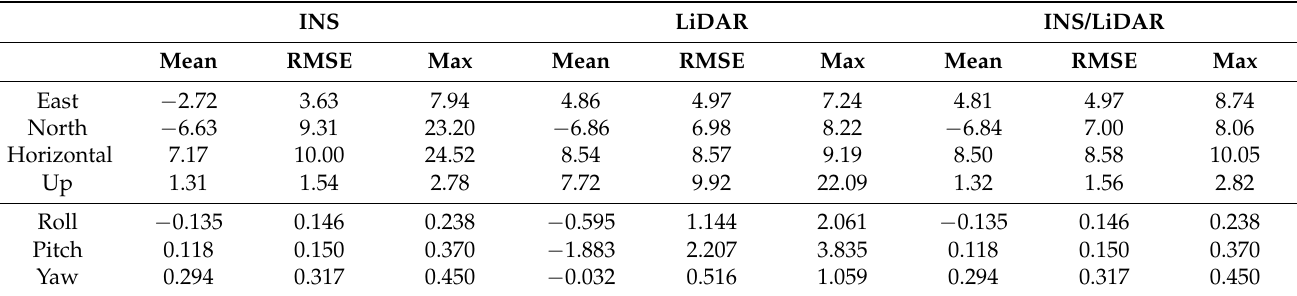
Table A21. D-28—position (m) and attitude (deg) error